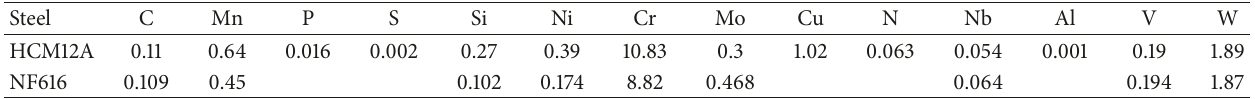
Table 1: Chemical composition of HCM12A and NF616 (in wt%).